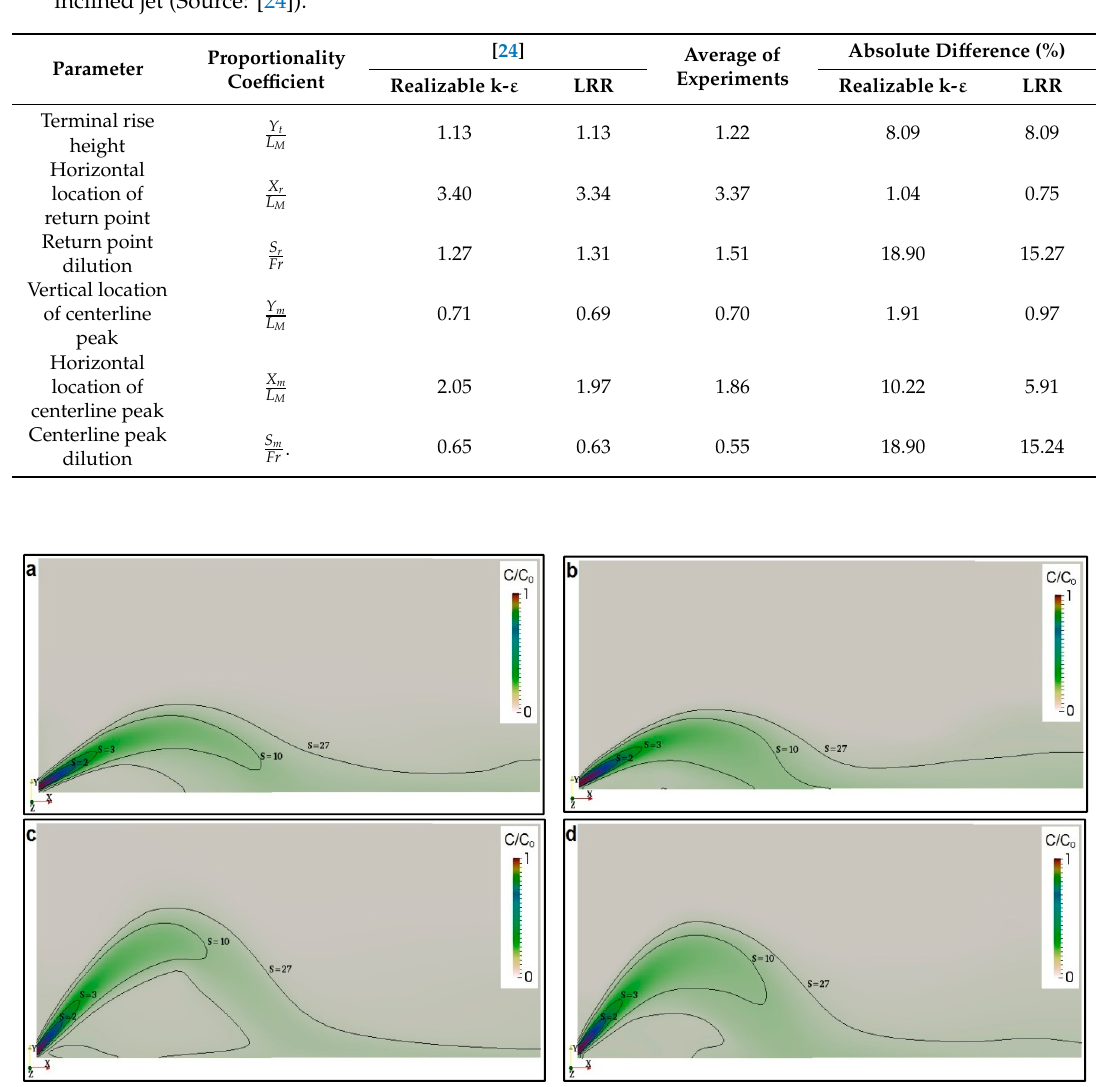
Table 3. Evaluation of performance of two turbulence models (realizable k- ε and LRR models) for 30 ◦